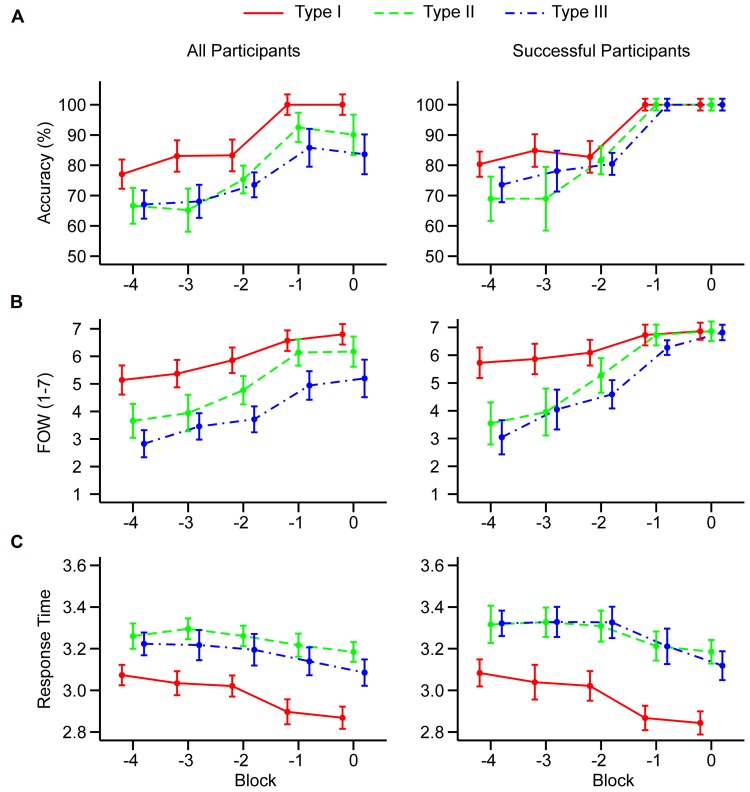
Mean accuracy (A), feeling-of-warmth judgments (B), and log10 transformed response times (C) in the last five learning blocks. Results are shown separately for all participants (left column) and for participants who successfully learned all three tasks (right column). Blocks are counted relative to the end of the learning session. Error bars represent 95% within-subjects confidence intervals computed following Cousineau (2005) and Morey (2008).